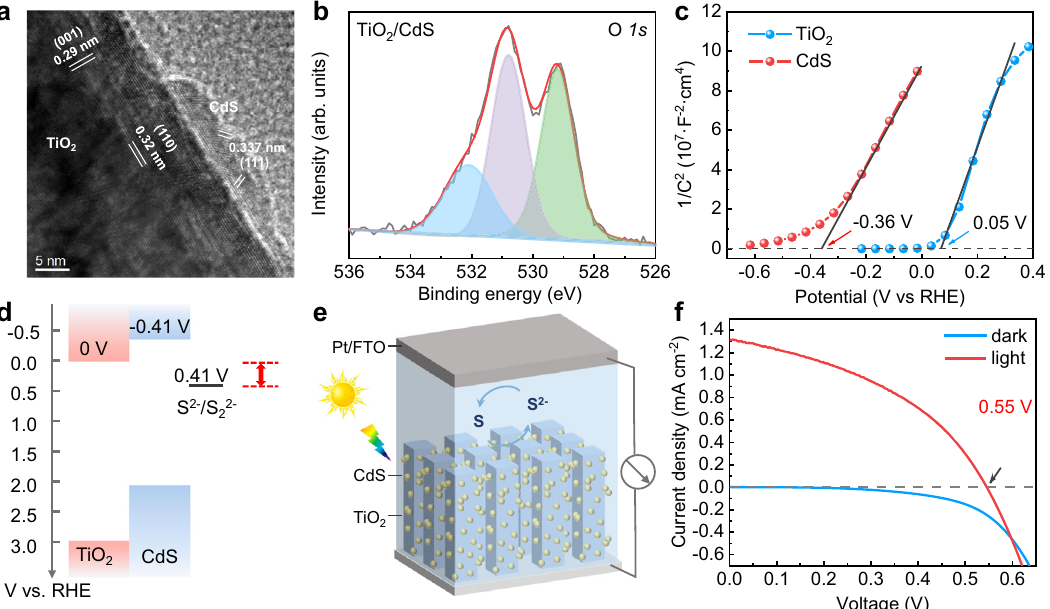
Fig. 1 Characterization and V OC of TiO 2 /CdS. a A TEM image of TiO 2 /CdS, ( b ) XPS spectra of O 1 s of TiO 2 /CdS, ( c ) Mott – Schottky plots of TiO 2 and CdS in 1 M Na 2 S aqueous solution, ( d ) band positions of a TiO 2 /CdS heterojunction and redox potential of S 2 − /S, ( e ) a schematic diagram of a TiO 2 /CdS quantum-dot-sensitized solar cell, and ( f ) I – V curves of TiO 2 /CdS quantum-dot-sensitized solar cells under illumination and in the dark. Electrolyte: 0.5 M Na 2 S, 2 M S, and 0.2 M KCl in water/methanol (3:7 by volume). Light source: a Xe lamp with an AM 1.5 sunlight-simulator fi lter, light intensity: 100 mW/cm 2